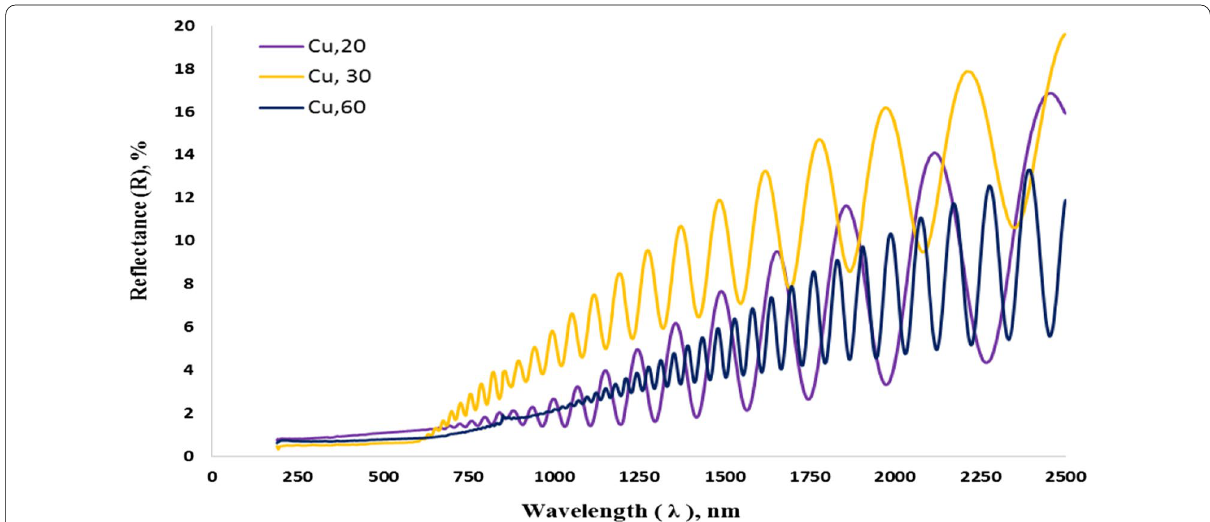
Fig. 8 Comparison between reflectance measurements of samples colored by Cu at different anodization times of 20, 30 and 60